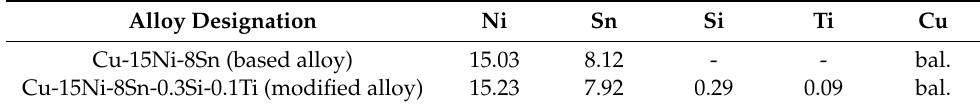
Table 1. Chemical compositions of the as-cast alloys